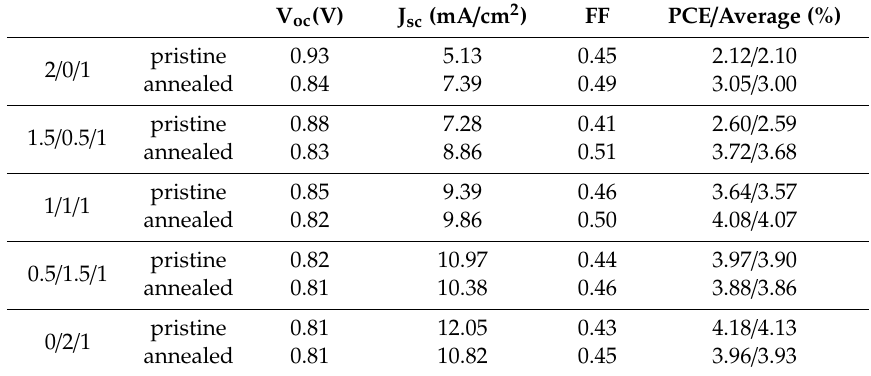
Table 1. Device parameters of TQ1 / PCE10 / PNDI-T10 blend films with di ff erent blend ratios cast from chloroform (CF). The average values are obtained based on 4